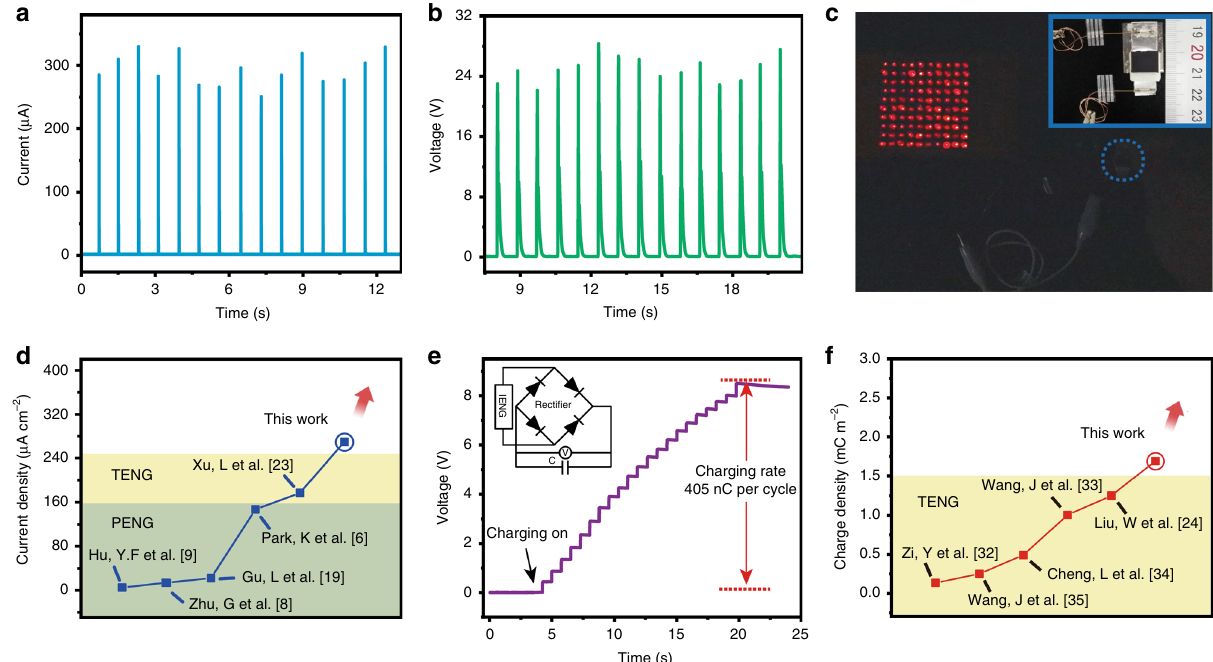
Fig. 5 Output performance of the IENG and its position in reported works. a , b The recti fi ed current and voltage signals. c 100 red LEDs are instantaneously lighted up by the IENG without storage process. Inserted image shows optical image of the IENG, and the black rubber on it is used to uniformly disperse the stress. d The maximum current density of our IENG calculated from recti fi ed current signals in a and some representative PENGs and TENG. e Charging curve for a 1 μ F capacitor, and the corresponding charging rate is 405 nC per cycle. f Charge density of our IENG calculated from the charging curve in e and selected representative